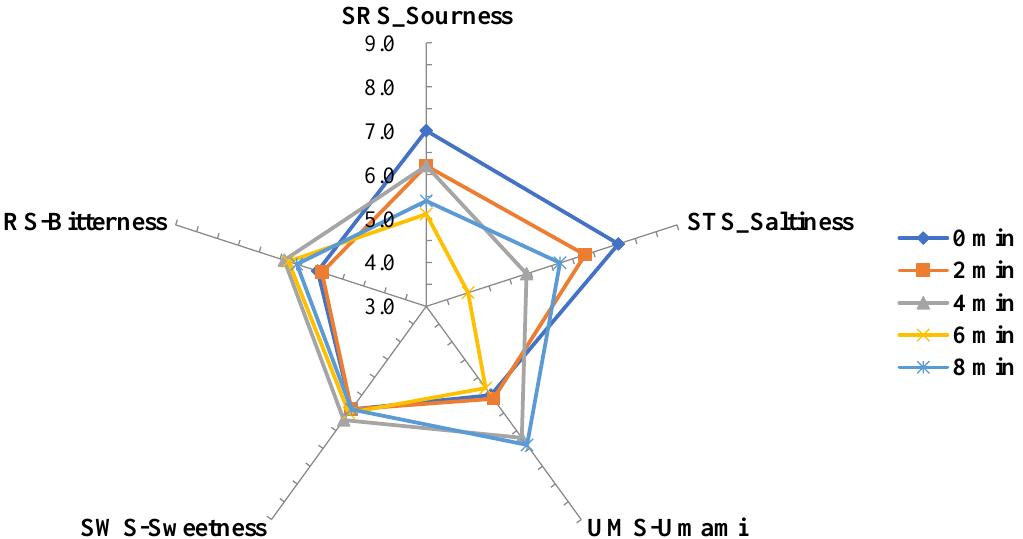
Figure 1. Chemical measures associated with sensory attributes of P. frutescens Britton var. acuta Kudo during the roasting using E-tongue .